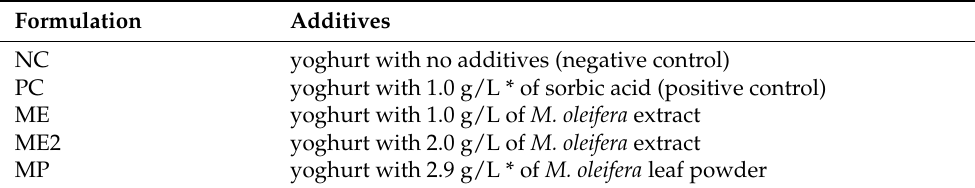
Table 7. Additives incorporated in the different yoghurt formulations produced.